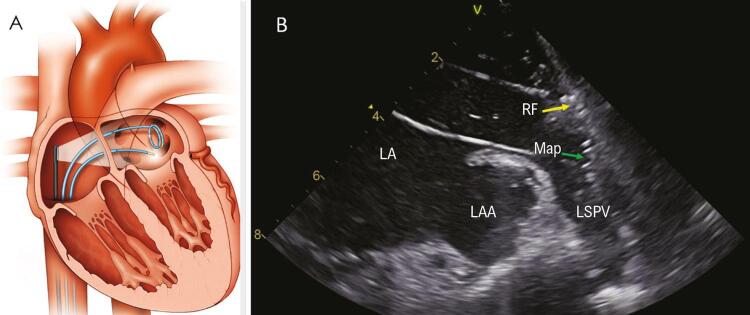
Use of intracardiac echo (ICE) during AF ablation. A) Schematic diagram showing the ICE catheter in the right atrial cavity with the ultrasound beam directed to guide the two transeptal punctures and positioning of circular mapping and ablation catheters in LA. B) ICE image demonstrating PV antral positioning and tissue contact during RF delivery around the left superior PV (VPSE). LA: left atrium; LAA: left atrial appendage; Map: mapping catheter; RF: ablation catheter.